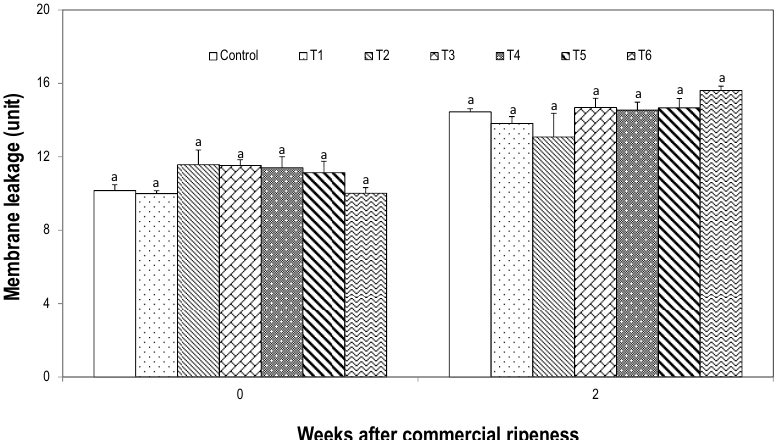
Figure 4. Effect of CPPU treatments at different stages on fruit membrane leakage as fruit became overripe on tree. CK represents the control, while T1, T2, T3, T4, T5 and T6 represent spraying 5 mg/L CPPU at 2, 4, 6, 8, 9 and 10 weeks after female bloom. Different letters indicate significant difference among treatments at p < 0.05, Duncan’s multiple range test.